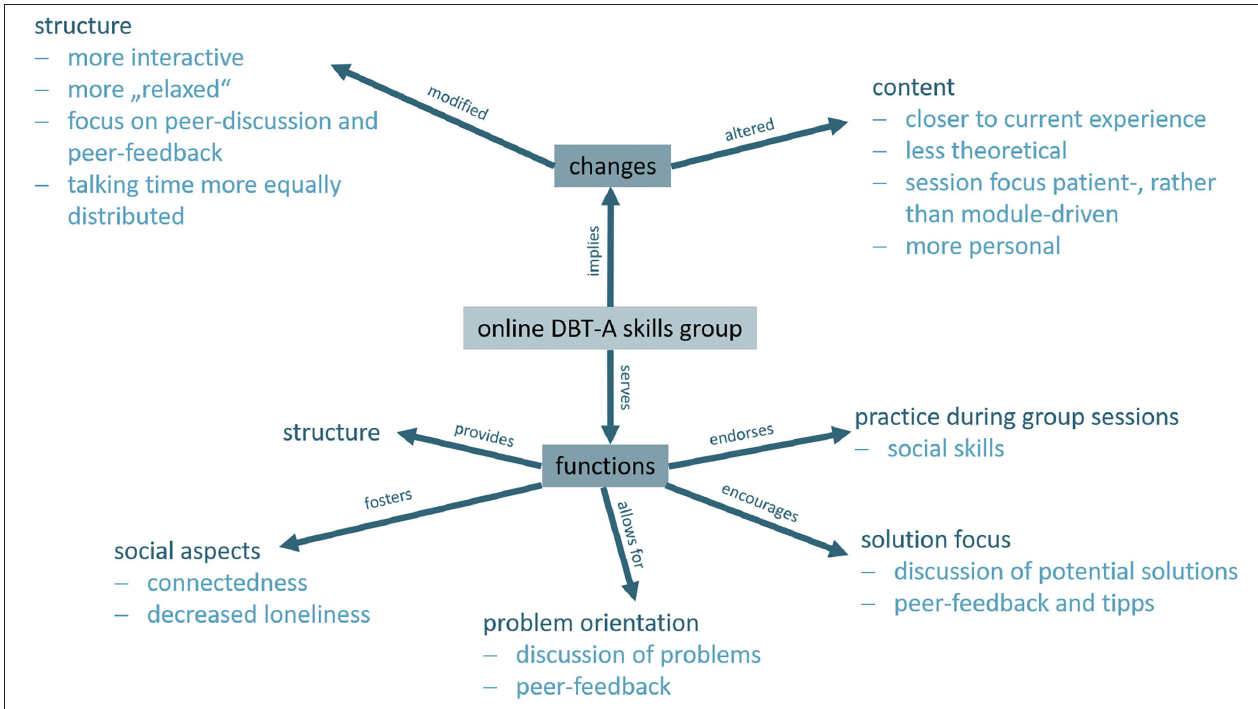
FIGURE 1 | Related themes elaborated during Inductive Category